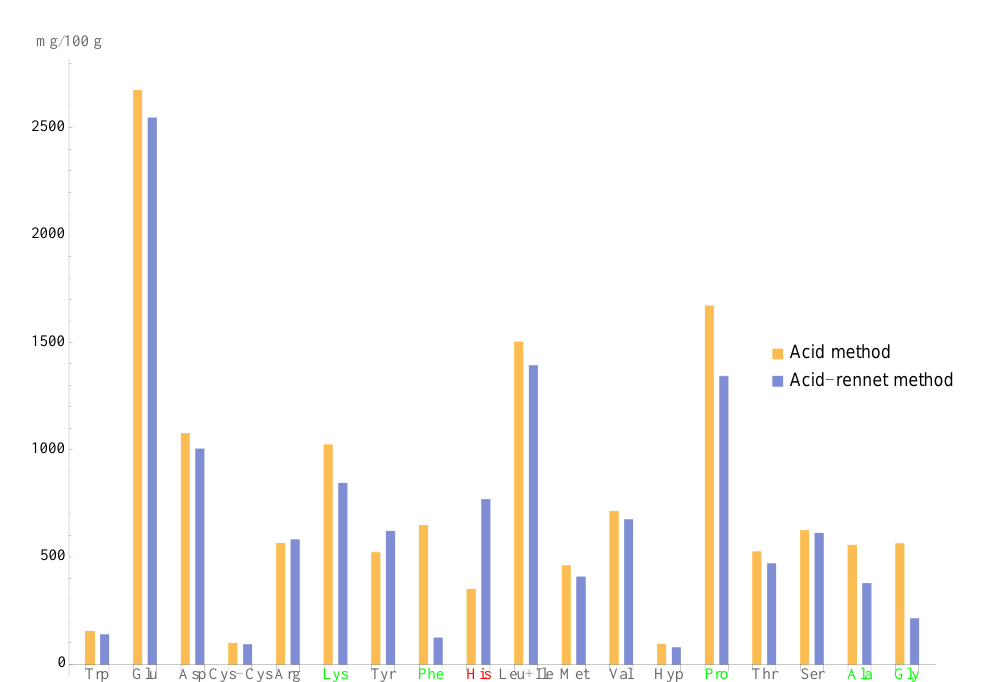
Figure 4. Amino acid profiles of the acid and fermented curd samples. Red: amino acids with content that was higher in the fermented curd samples. Green: amino acids with content that was higher in the acid curd samples. Black: no significant statistical difference in amino acid content. Table 6. Properties of curd samples with different fat content. a – c : Different superscript letters mark significant statistical difference between means of RBV.